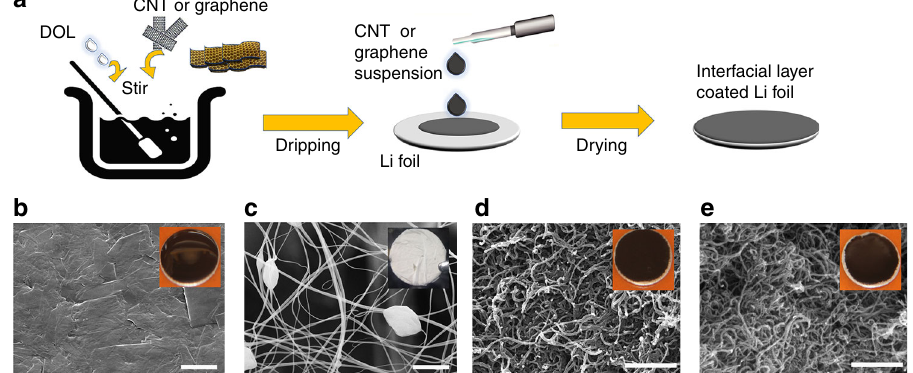
Fig. 2 Synthesis and characterization of Li metal anodes with various upper interfacial layers. a Schematic of interfacial layer fabrication in a glove box. Graphene, ZnO/CNT, or CNT were mixed with DOL, and the suspension was dripped onto the Li foil at 100 μ L cm – 2 and dried at 80 °C for 1 h. b – e Top- view SEM images of b graphene, c electrospun fi ber, d ZnO/CNT, and e CNT interfacial layer. The insets show digital photographs of the corresponding Li foils with interfacial layers. Scale bar, 2 μ m for b and c , and 500 nm for d and